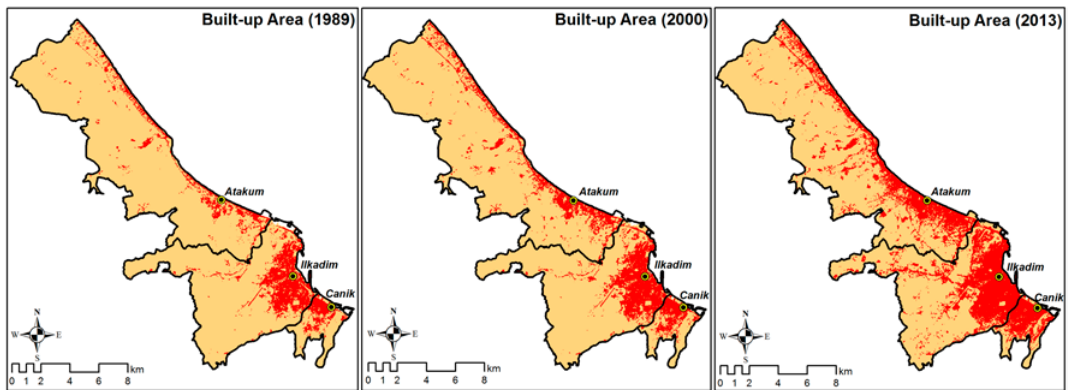
Fig. 3. Built-up and non-built-up areas in Atakum, Ilkadim and Canik for 1989, 2000, and 2013. The coastal areas were increasingly filled with built-up areas between 1989 and 2013, and the spread started